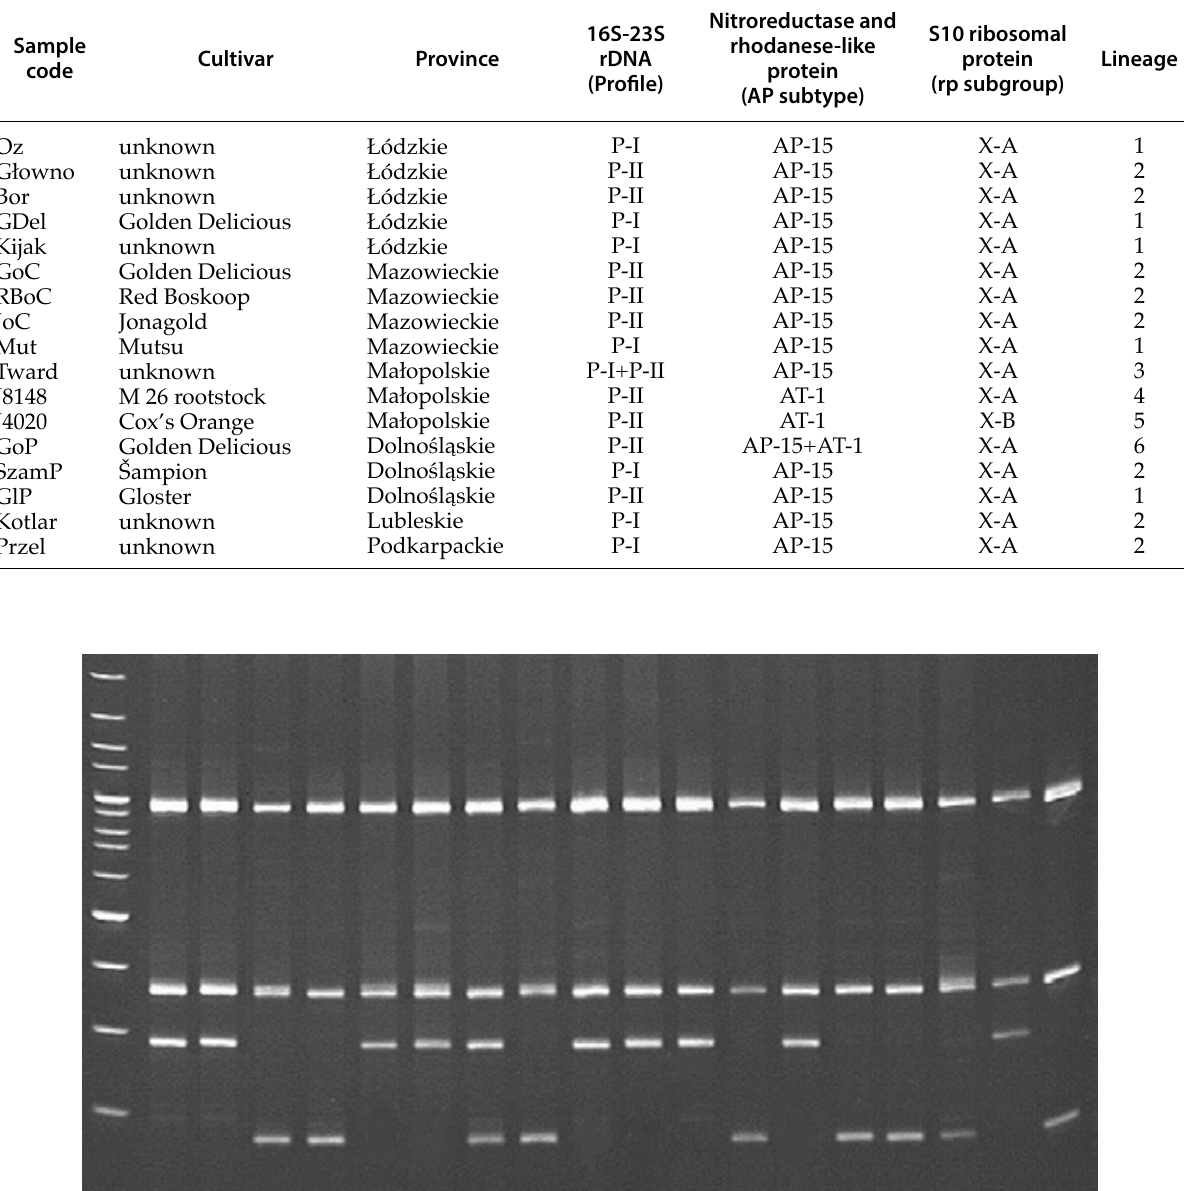
Table 2. Results of multigene RFLP analyses of ‘ Candidatus Phytoplasma mali’ strains detected from the survey of apple trees in Central and Southern Poland during 2010-2013.